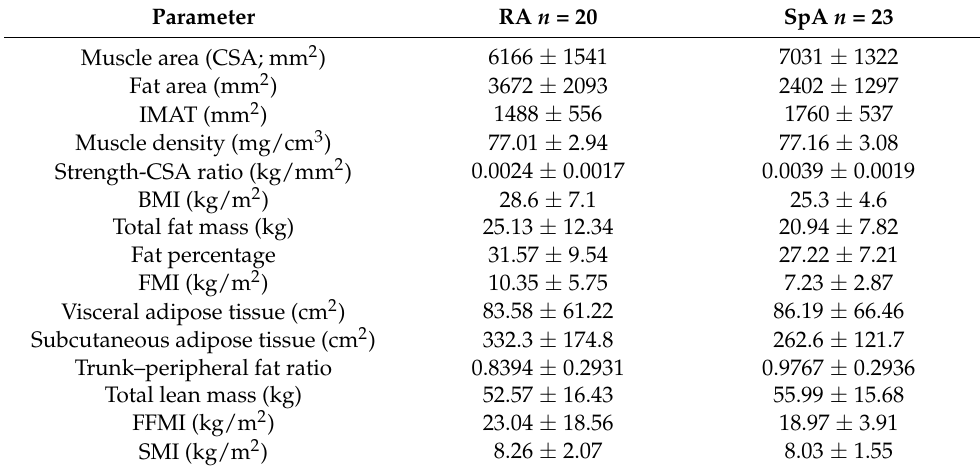
Subcutaneous adipose tissue (cm 2 ) Trunk–peripheral fat